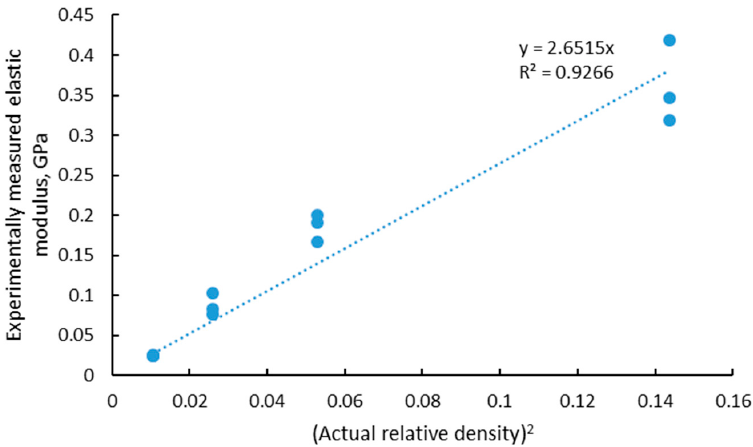
Figure 5. Relationship for experimentally measured elastic modulus and squared relative density of the manufactured LPBF the manufactured LPBF lattices.